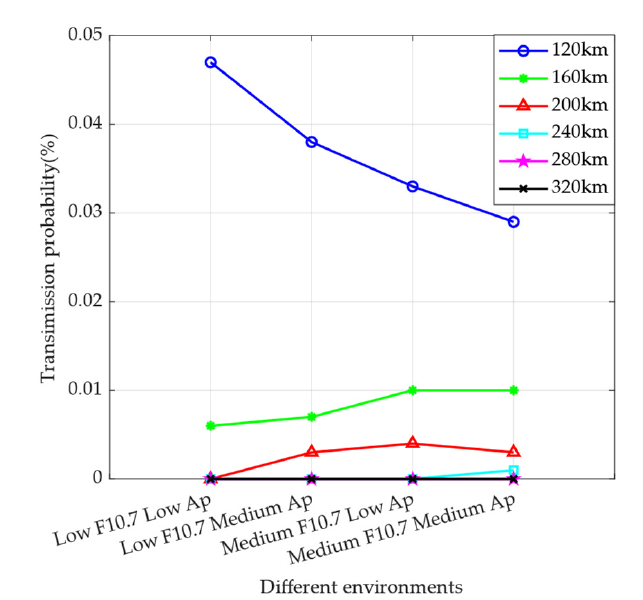
Figure 7. Simulation results of the attitude control jet under different environments. The x-axis represents the gradual intensification of solar activity and geomagnetic activity, where F10.7 represents the degree of solar activity and Ap represents the degree of geomagnetic activity. The y-axis represents the transmission probability, which is the ratio of the number of particles received at the sensor sampling port to the total number of particles.